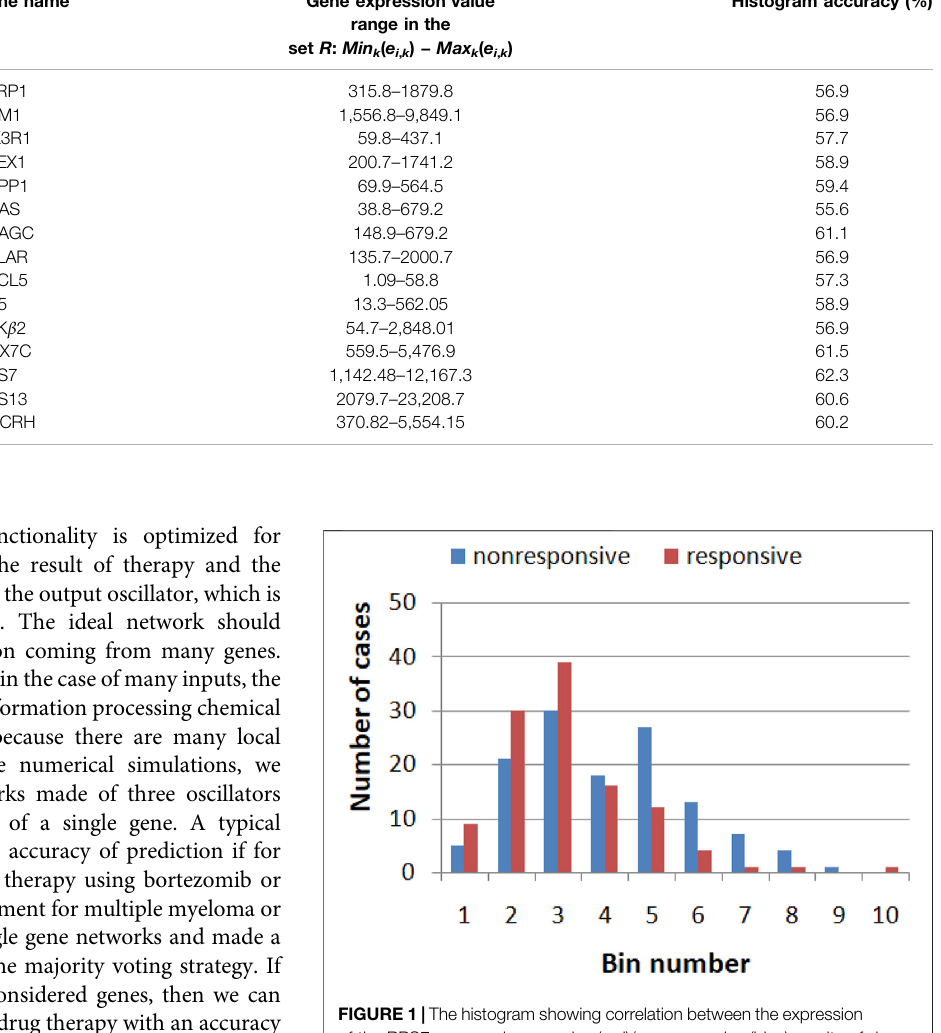
TABLE 1 | Genes considered for determining the drug response and their range. Gene no. i